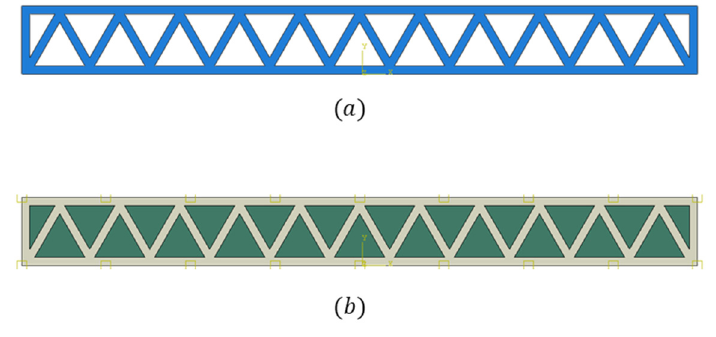
Figure 5. Geometry of wall configuration: ( a ) with cavity; ( b ) with cavity insulation.